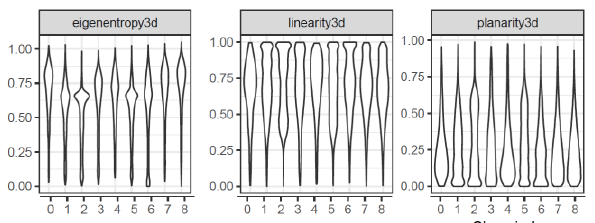
Figure 3. Frequency distribution of the three features that have most importance for both RF and TF methods (see Table 1 for class labels).